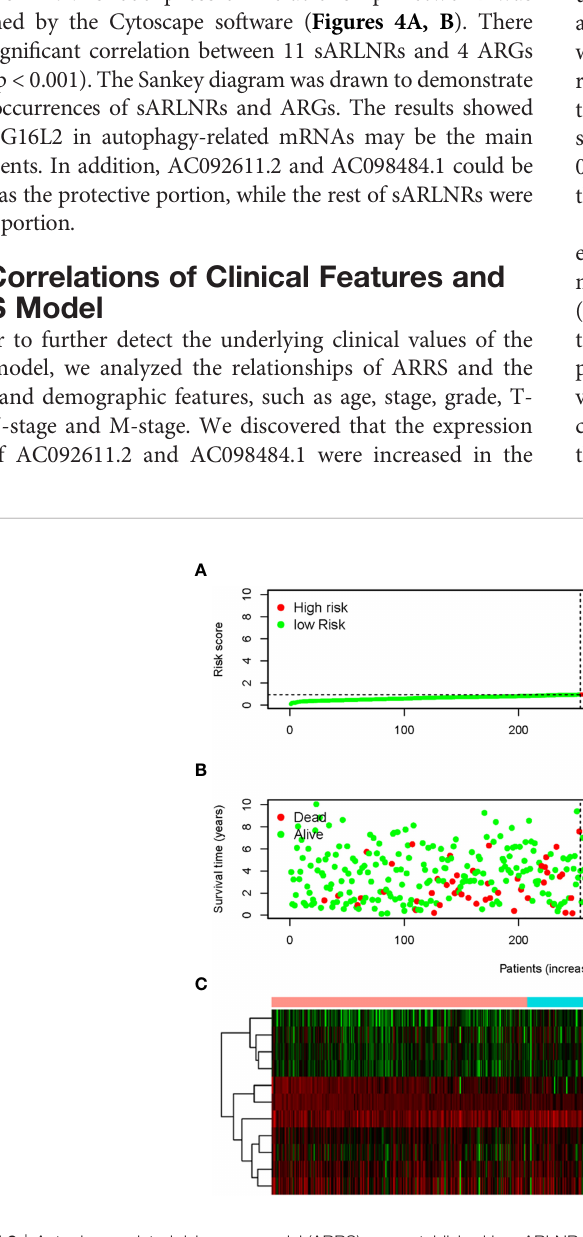
FIGURE 2 | Autophagy-related risk score model (ARRS) was established by sARLNRs. The risk score distributions in the high-risk group and the low-risk group (A) . Survival status between the high-risk group and the low-risk group (B) . The heatmap of expression levels of sARLNRs (C)